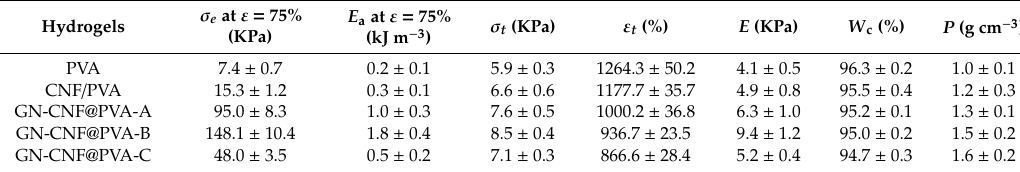
Figure 5. ( a ) Compression and ( b ) energy absorption graphs of various gels; ( c ) scanning electron microscope (SEM) image of GN-CNF@PVA-B hydrogel; ( d ) tensile graphs of PVA, CNF / PVA and GN-CNF@PVA gels; ( e ) demonstration of the stretchability of the GN-CNF@PVA-A gel. Table 3. Physical-mechanical performances of original gels.